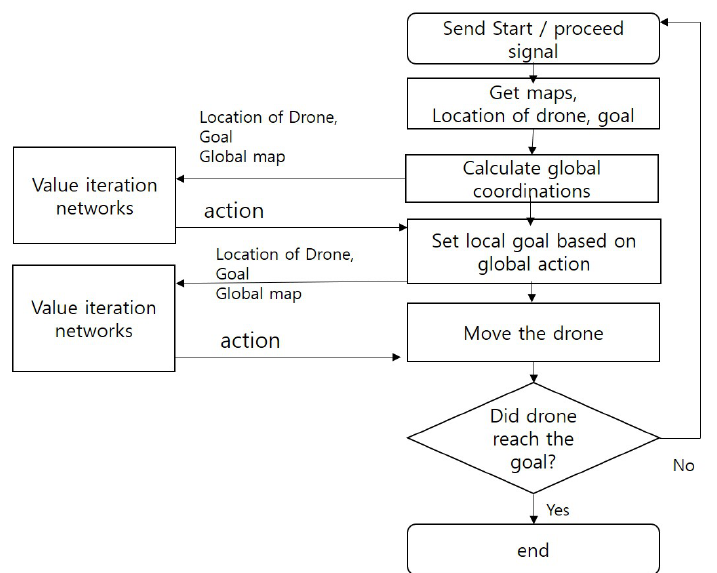
Figure 4. Procedure of Hierarchical VIN.